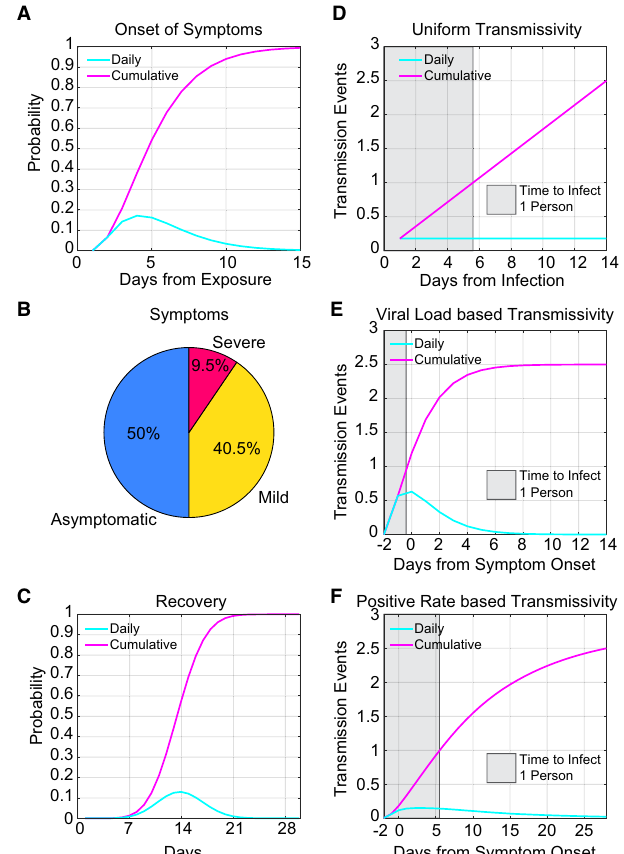
Figure 3. Model Parameters. ( A ) Probability distribution of onset of symptoms from He et al. 6 ( B ) Breakdown of symptom groups in the model. ( C ) Probability distribution of recovery based on a median time to recovery of 14 days. ( D ) R0 of 2.5 scaled to a uniform transmission probability distribution. The gray box indicates where the cumulative probability reaches 1. Individuals must be detected prior to this, on average, in order to reduce the apparent R0 below 1. ( E ) The R0 of 2.5 scaled to the viral load based on He et al. The gray box is the same as above. ( D ) The R0 of 2.5 scaled to the positive test rate from Kucirka et al. 7 . This was done because the changes in positive test rate are likely related to viral load, and so may be an alternative representation of transmission likelihood. The gray box is the same as